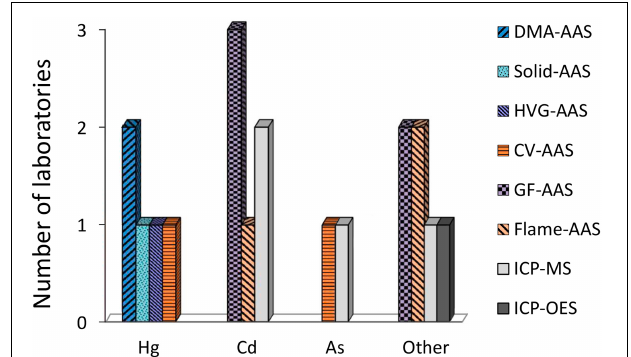
FIGURE 5 | Analytical methods used for metal analysis in biota by different laboratories. DMA, Direct Mercury Analyzer; Solid AAS, Solid